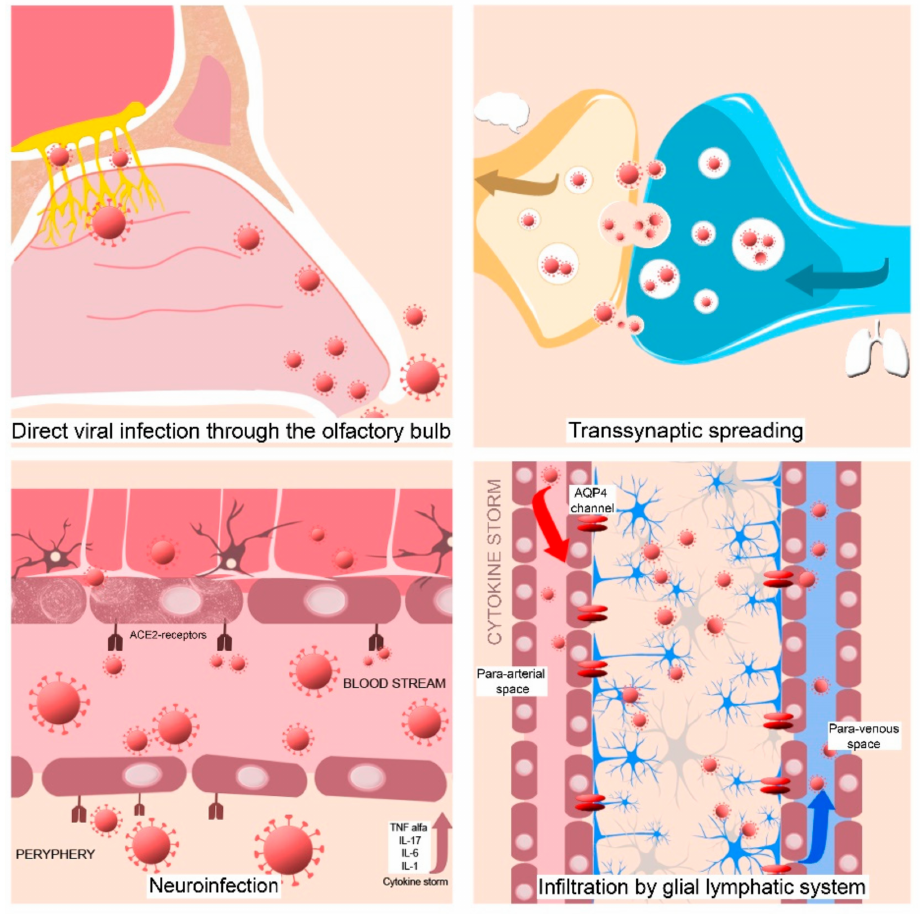
Figure 4. Graphical representation of the proposed mechanisms for neuro-invasion. Endothelial angiotensin-converting enzyme 2 receptors (ACE2-receptors), anti-aquaporin 4